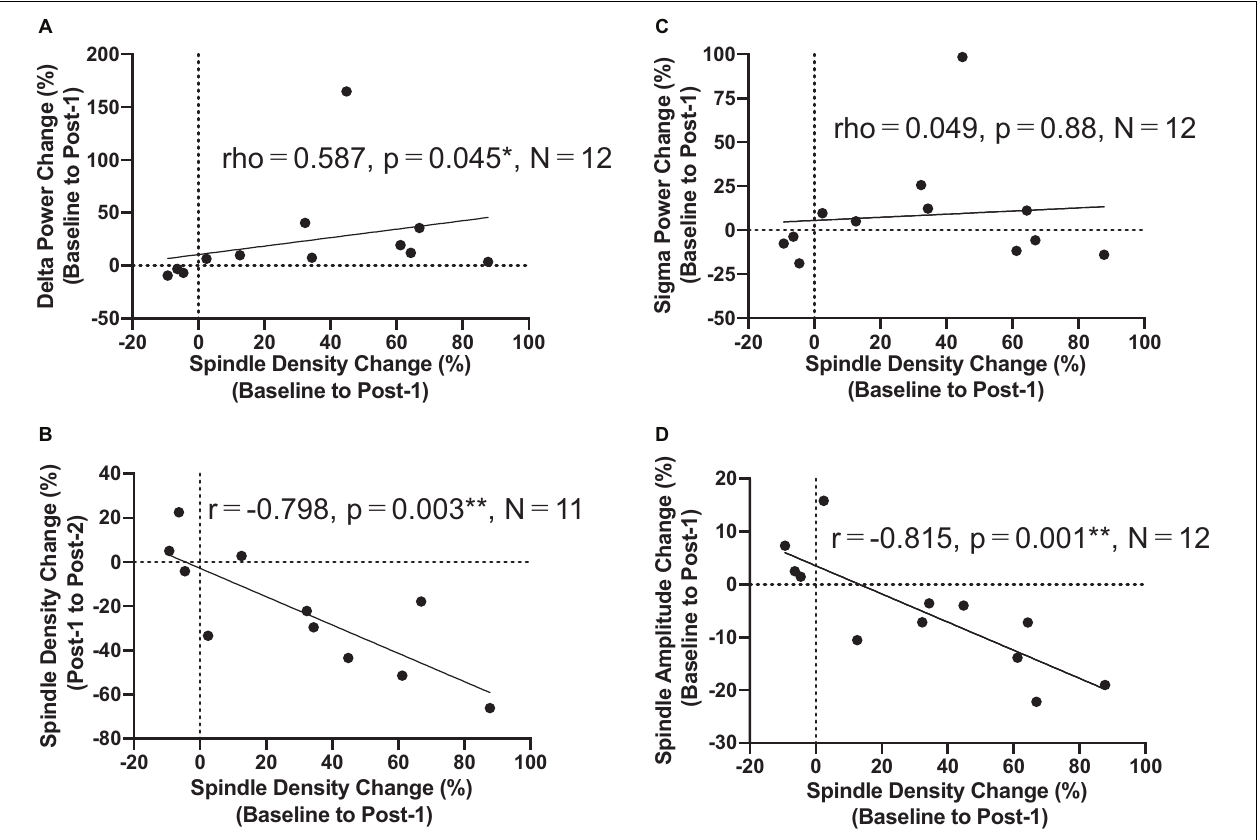
FIGURE 3 | Correlation findings. (A) Spindle density change from Baseline to Post-1 was positively correlated with the delta power change during the same period (rho = 0.587, P = 0.045, N = 12). (B) Spindle density change from Baseline to Post-1 was negatively correlated with the spindle density change from Post-1 to Post-2 ( r = -0.798, P = 0.003, N = 11). (C) Spindle density change from Baseline to Post-1 was not correlated with sigma power change during the same period. (D) Spindle density change from Baseline to Post-1 was negatively correlated with the spindle amplitude change during the same period ( r = -0.815, P = 0.001,